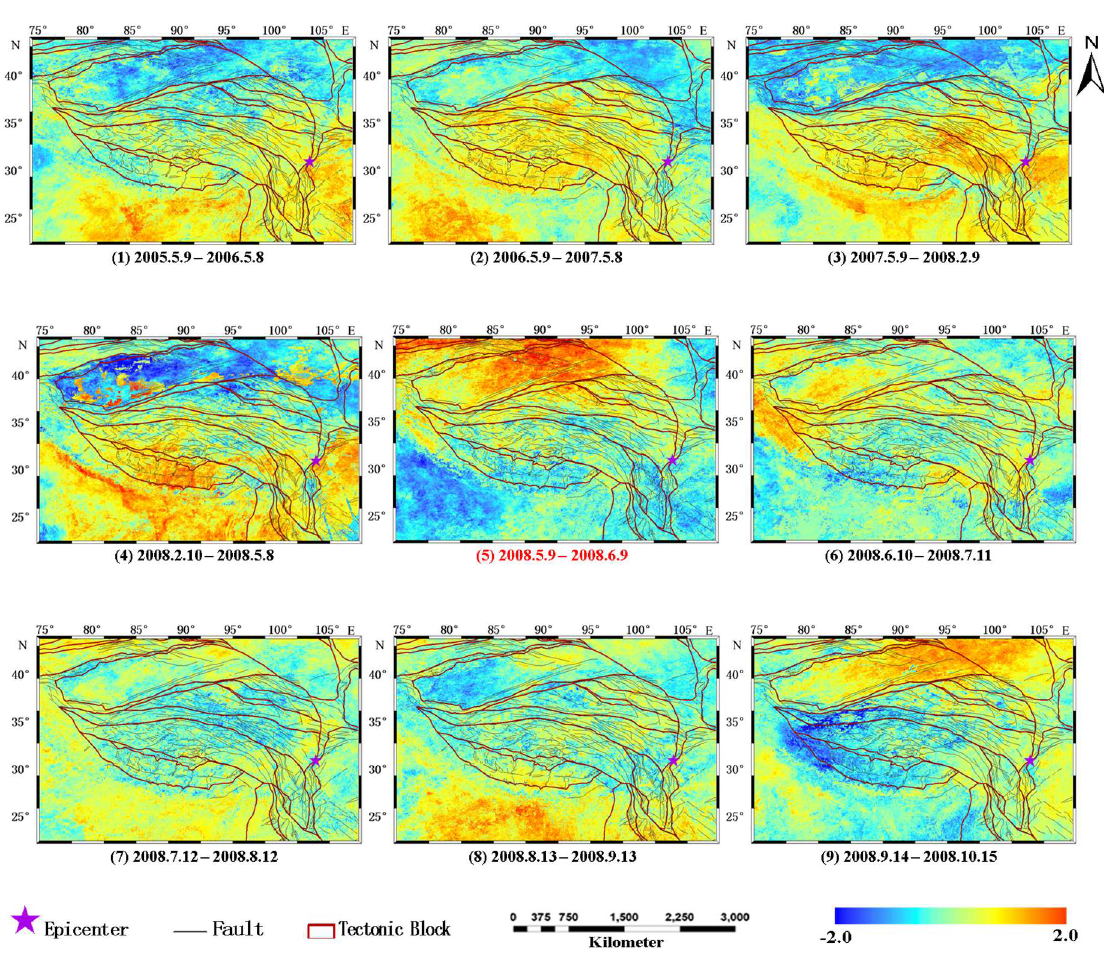
Figure 18. TIR anomalies spatio-temporal presentation of the Ms 8.0 Wenchuan earthquake event based on the RST method on the Tibetan Plateau.